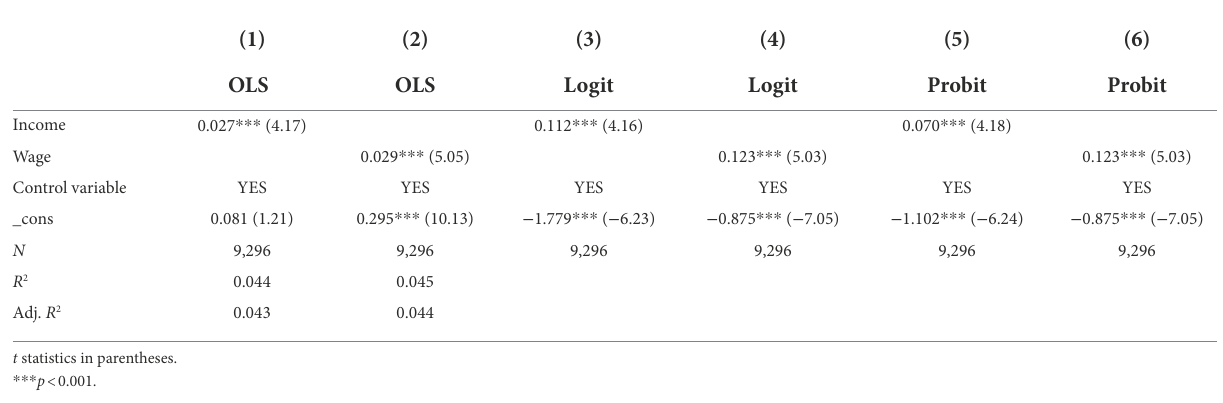
TABLE 5 Robustness test results.